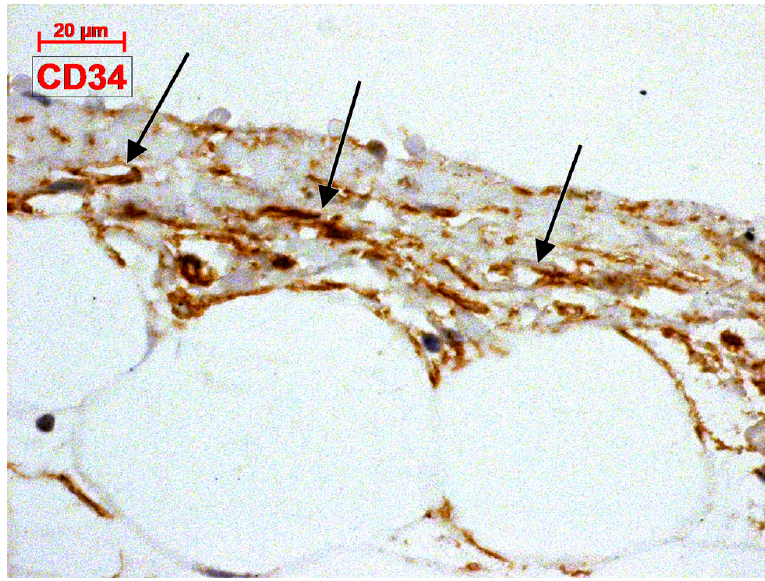
Figure 5. Human adult cardiac wall. Immediate submesothelial expression of CD34 includes nascent endothelial tubes